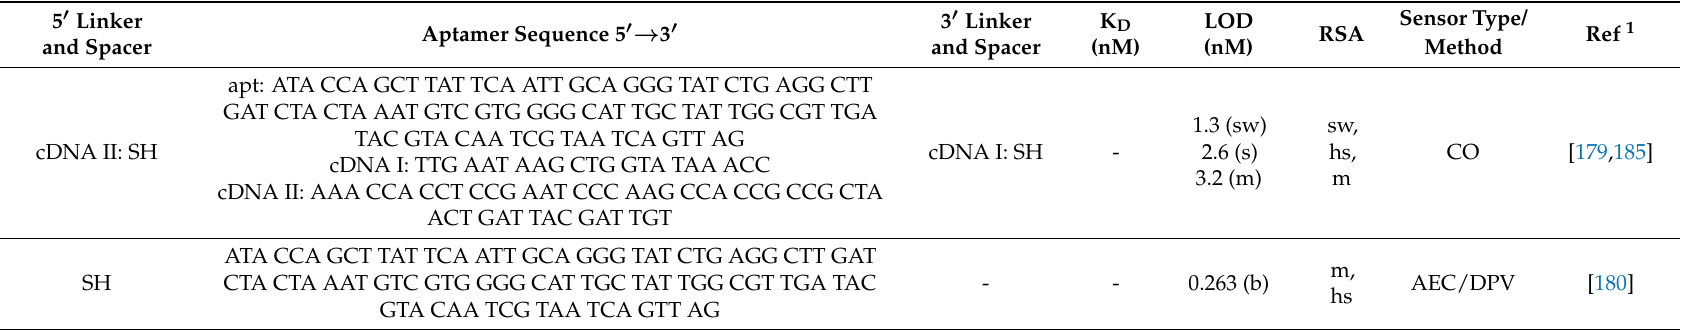
Table 10. Aptamer sequence, dissociation constant (K D ), limit of detection (LOD), real sample analysis (RSA), and realized sensor type and measuring method for ciprofloxacin, mentioned in the corresponding references (Ref). AEC = amperometric electrochemical, b = buffer, cDNA = complementary DNA, CO = colorimetric, DPV = differential pulse voltammetry, hs = human serum, m = milk, and sw = spiked water.